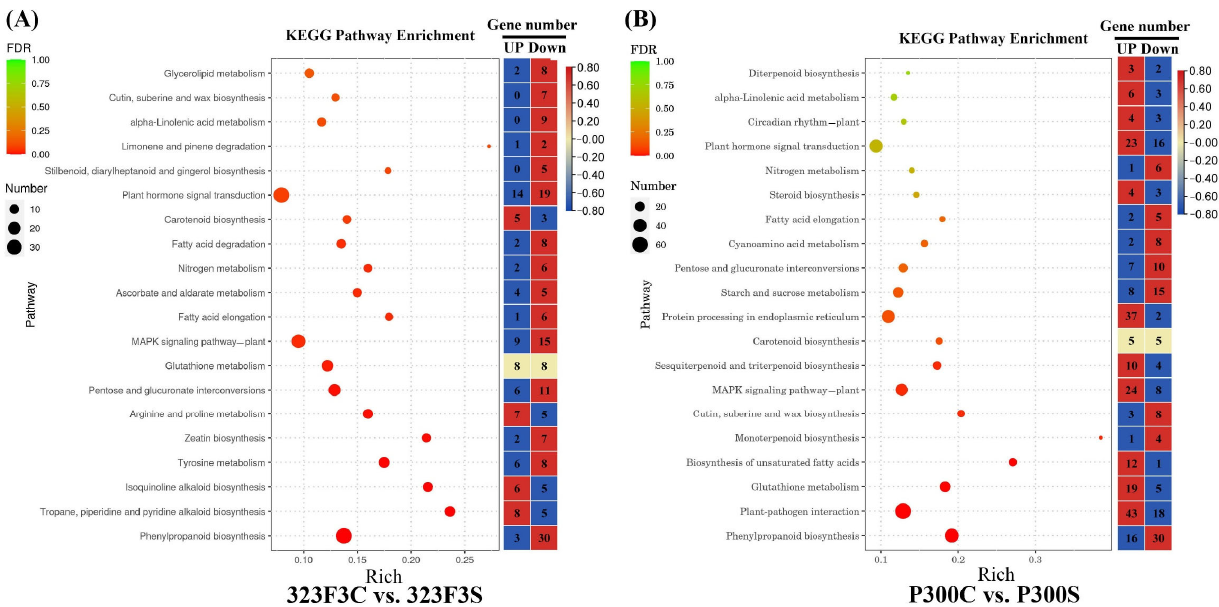
Figure 8. KEGG pathway enrichment analysis of the DEGs identified in the 323F3C vs. 323F3S ( A ) and P300C vs. P300S ( B ) comparisons. The topmost enriched 20 KEGG pathways with the lowest FDR values were selected for display. Rich factor refers to the ratio of the DEGS to the total number of annotated genes in each pathway. The numbers of up ‐ regulated and down ‐ regulated genes in each pathway are shown on the right side of each KEGG enrichment diagram.